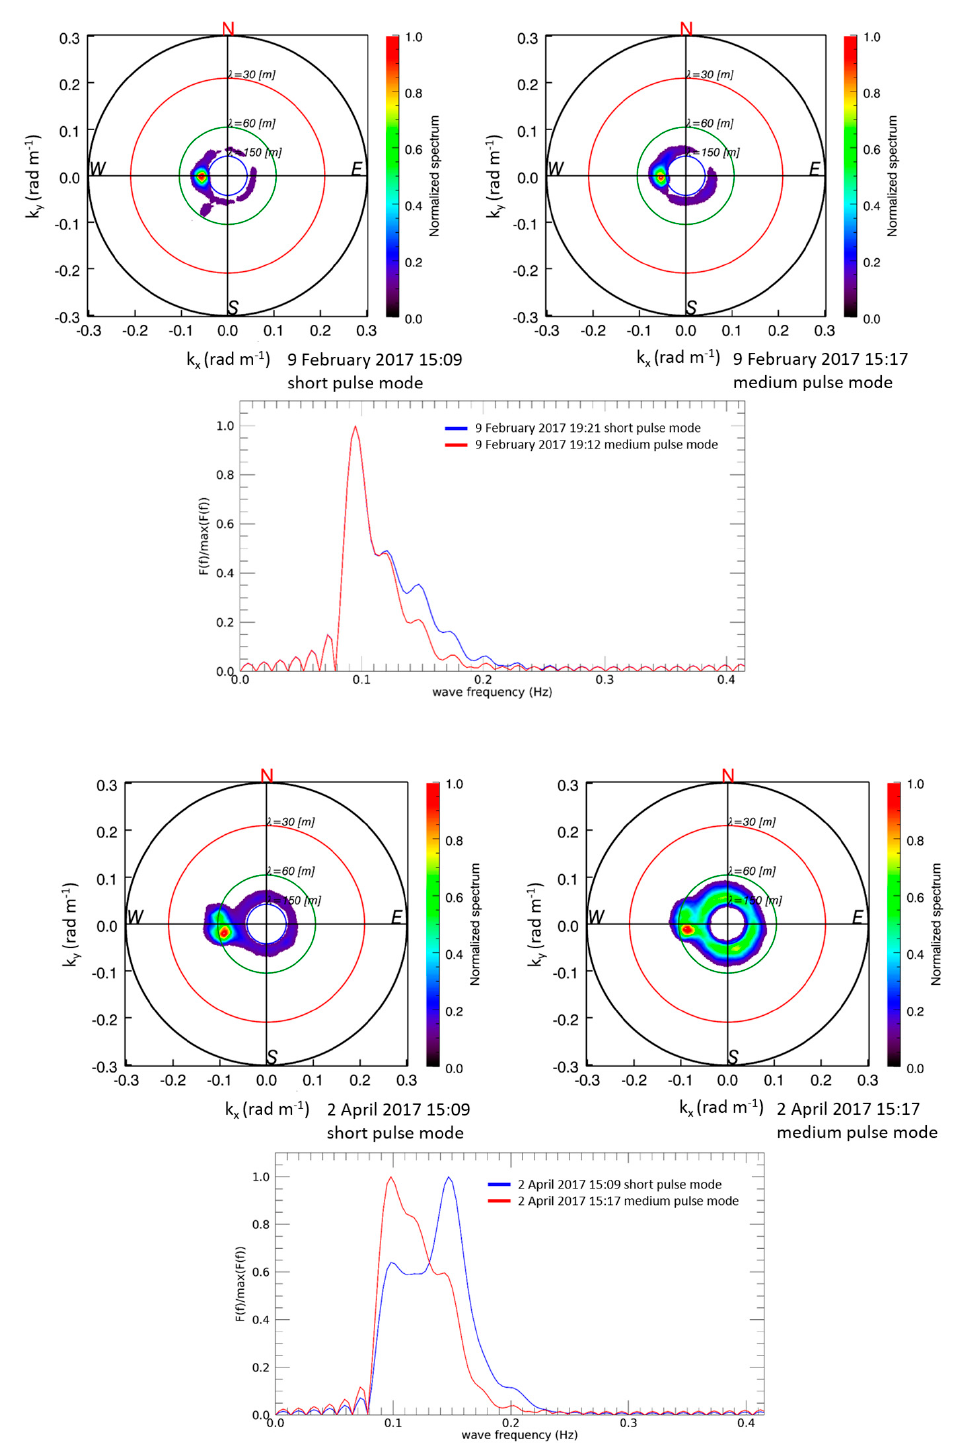
Upper panels of Figure 7 show the 2D directional spectra achieved from the reconstructed sea-wave for the short (left panel) and medium (right panel) pulse mode, respectively; the comparison between the 1D frequency spectra is depicted in the bottom panels of Figure 7.